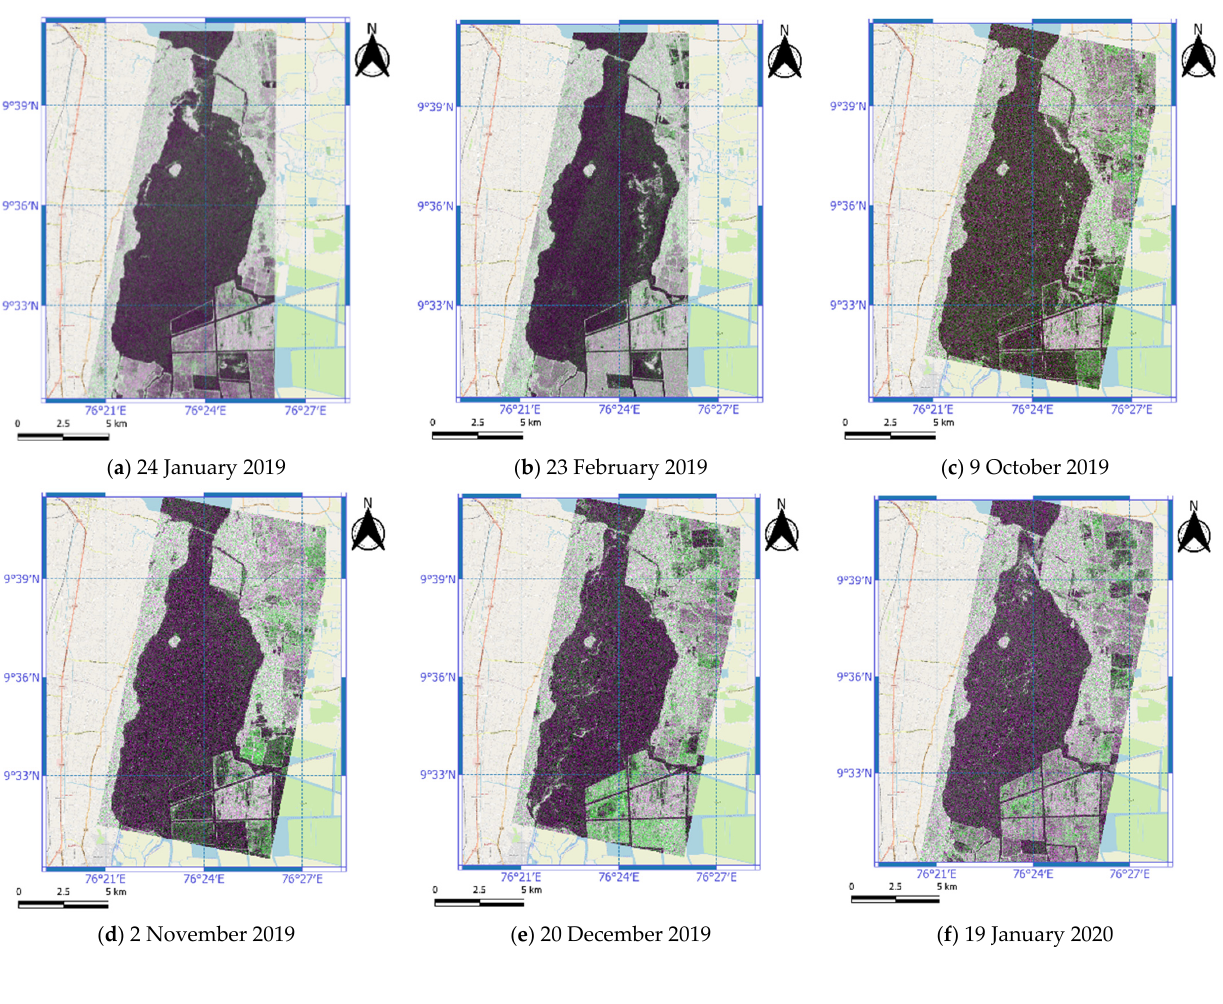
Figure 3. Water hyacinth infestation in Vembanad Lake, India. Image taken 26 January 2020.